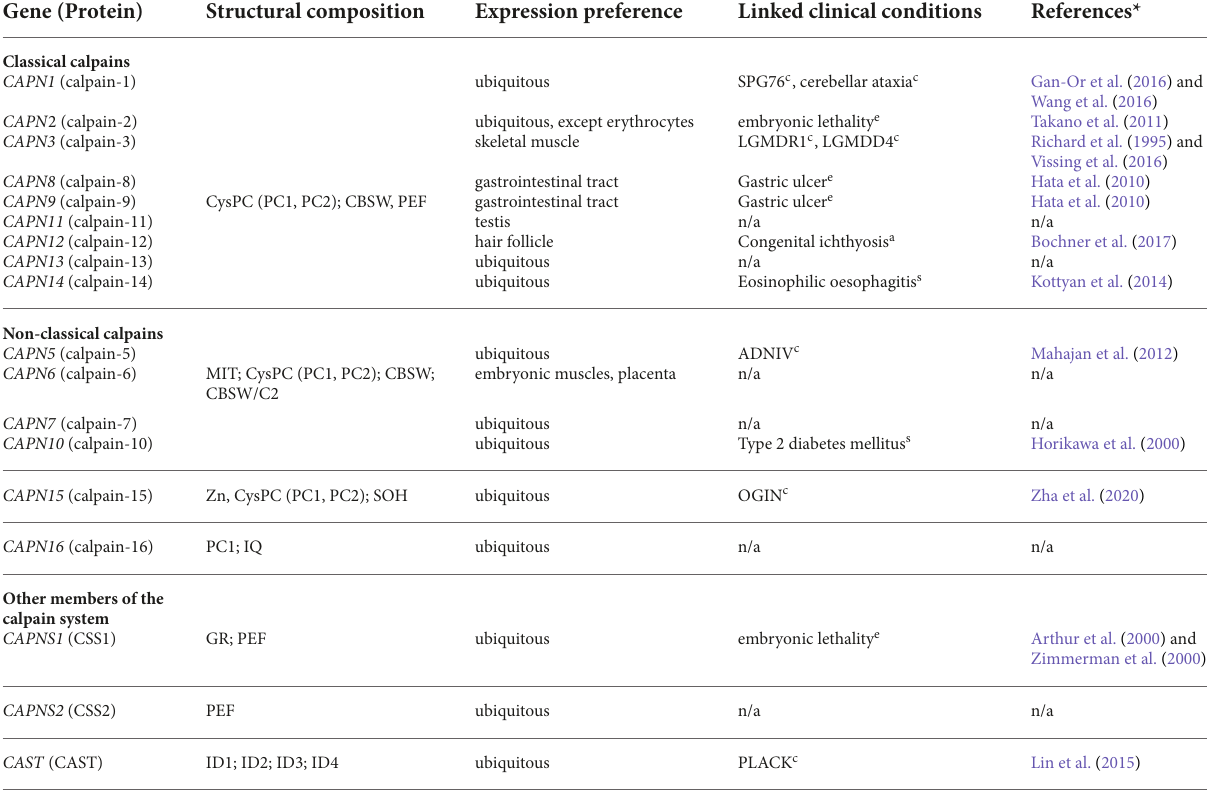
TABLE 1 Protein structure and expression preference of calpain system-related genes and associated clinical conditions. Gene